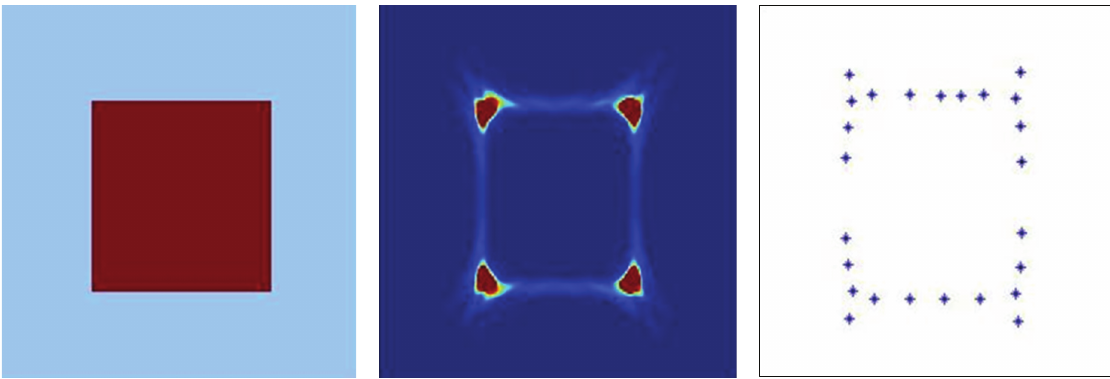
Figure 3: The original (a), SAR-processed (b), and scattering centers (c) images of a square PEC object.